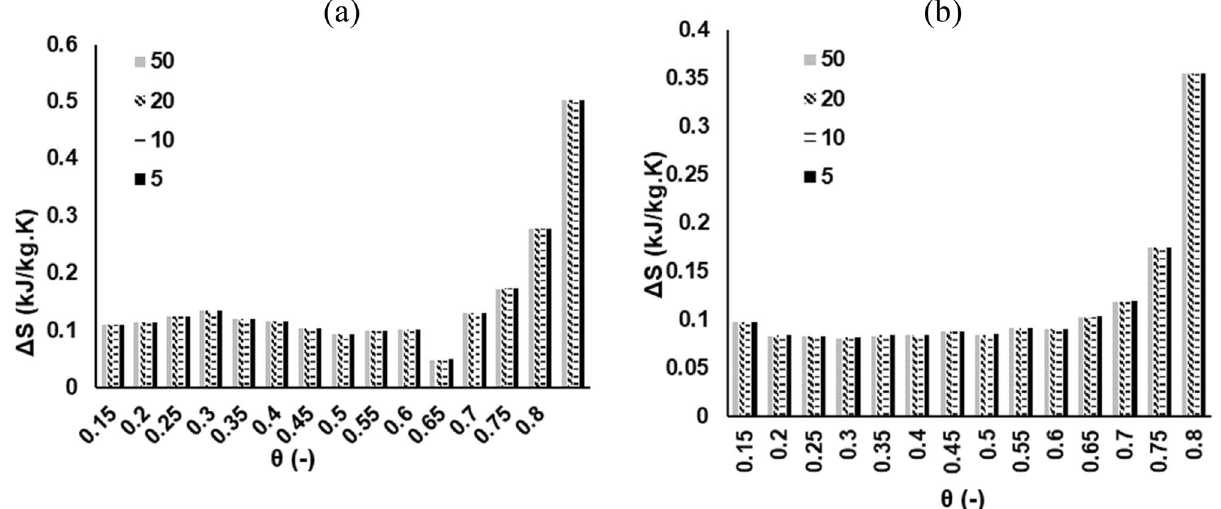
Figure 7. Plot of change of entropy ( (cid:31) S ) at 5, 10, 20, 50 K/min based on DFM (N 2 pyrolytic environment) for